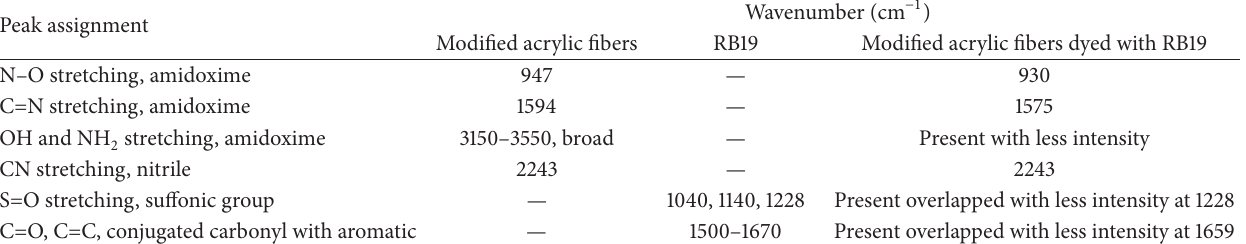
Table 2: FT-IR characteristic absorption peaks of modified acrylic fibers, RB19, and modified acrylic fabrics dyed with RB19.